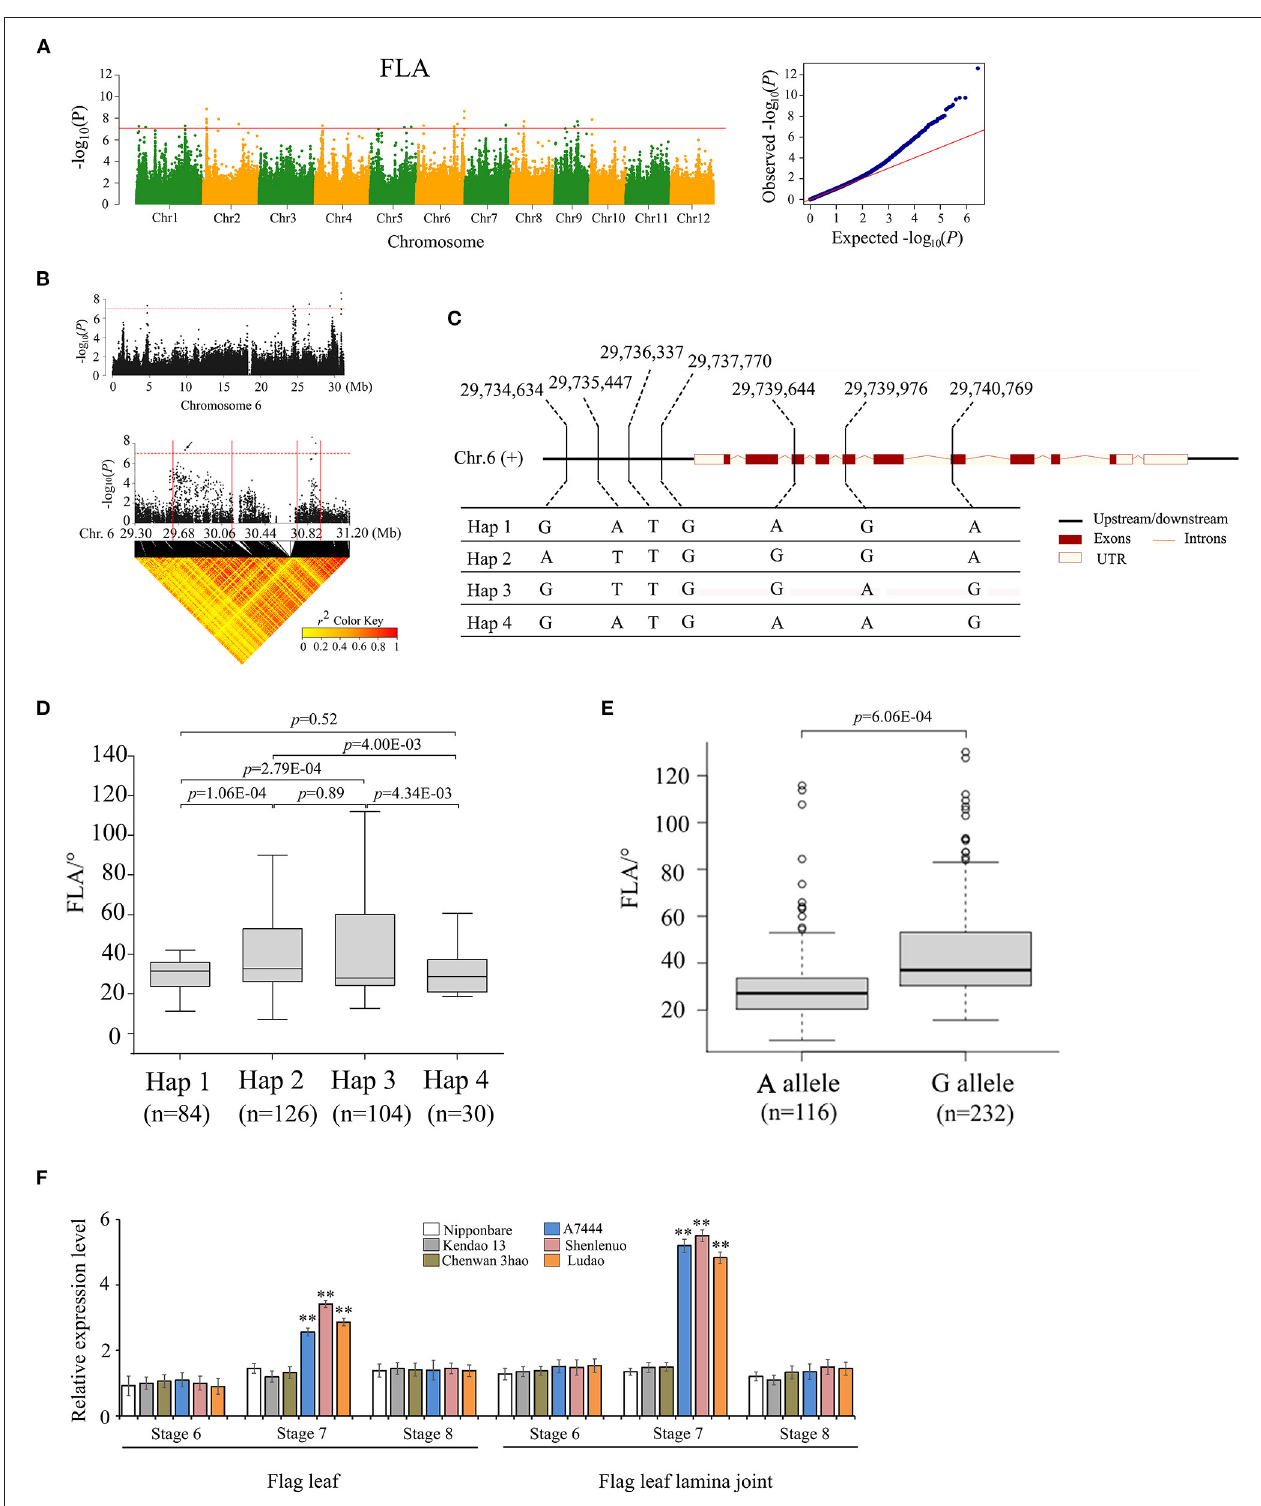
FIGURE 3 | Genome-wide association study for FLA and identification of the candidate gene OsFLA6 ( Os06g0704300 ). (A) Manhattan plots for FLA. Red line means the significance threshold (–log 10 P = 7.0). (B) Local Manhattan plot (top) and linkage disequilibrium (LD) heatmap (bottom) on chromosome 6. The arrow indicates the position of nucleotide variation in Os06g0704300 . The candidate region lies between the red solid lines. (C) Haplotypes of OsFLA6 associated with flag leaf angle